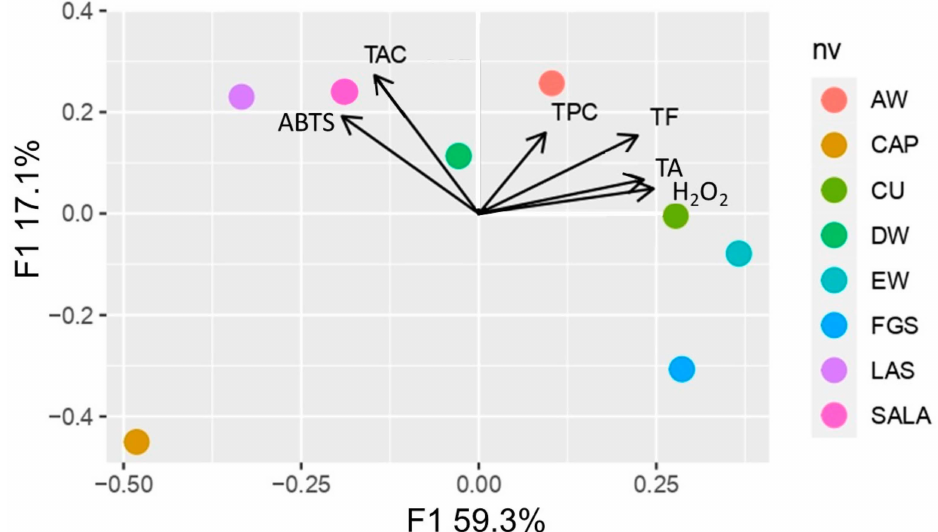
Figure 7. Main component analysis of the total phenolic content (TPC), total flavonoid (TF), total alka- loids (TA), total anthocyanin (TAC), and antioxidant activity (ABTS, and H 2 O 2 scavenging activity) of extracts from tobacco inflorescence waste obtained with conventional and non-conventional